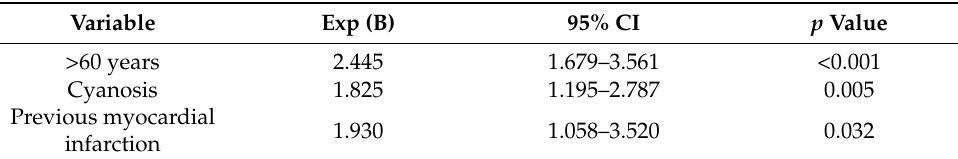
Table 4. Results of the multivariate Cox regression analysis to predict mortality in patients with